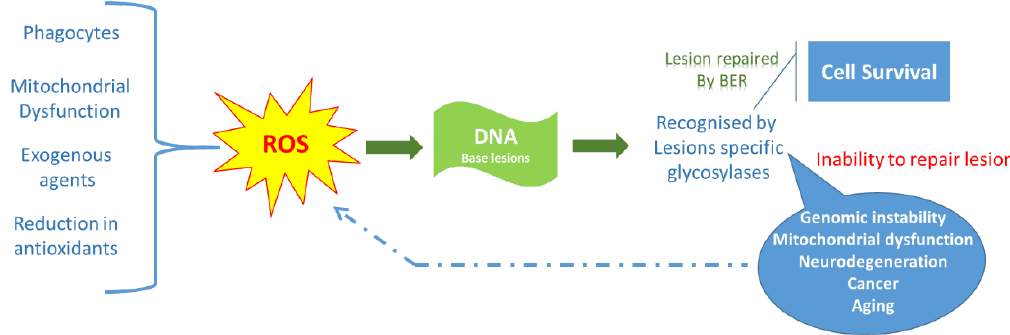
Table 2. A selection of enzymatic and protein antioxidant factors.